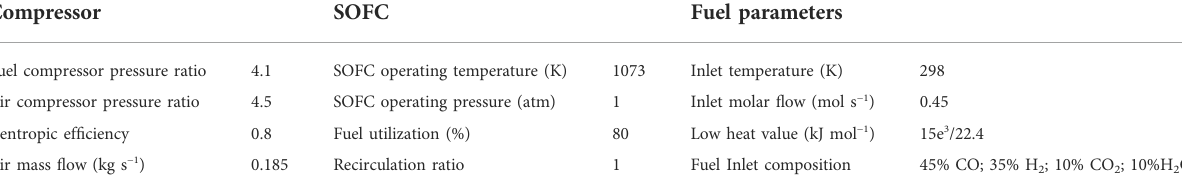
TABLE 1 Preliminary design conditions for the IGFC hybrid system.